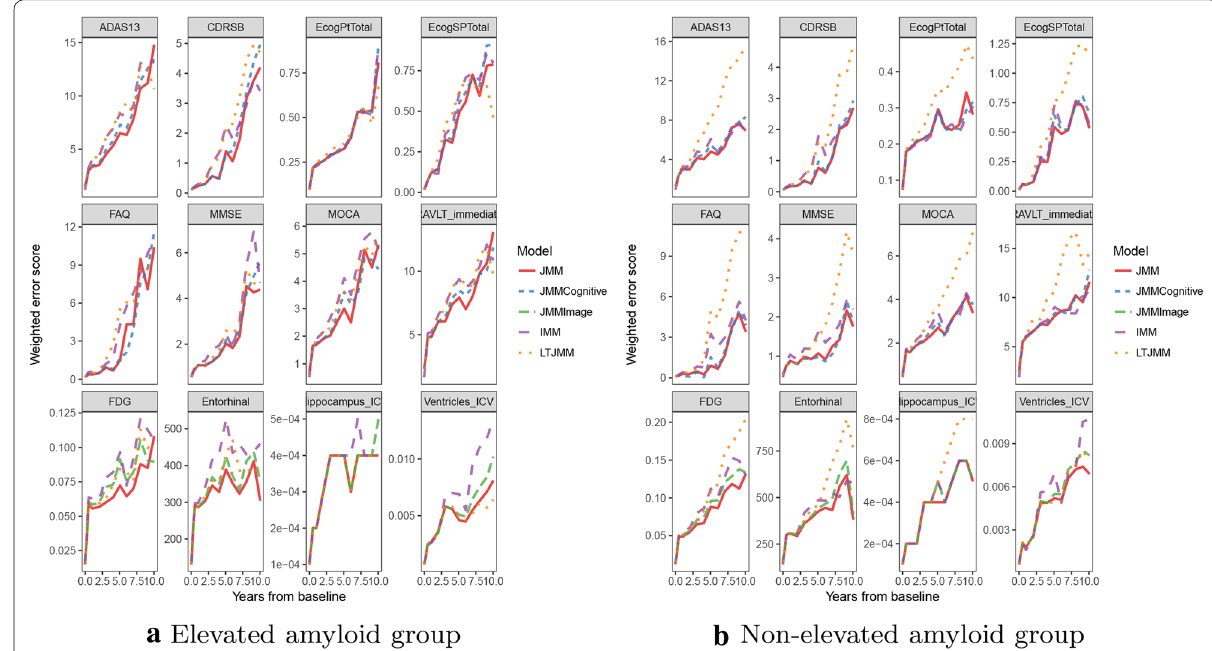
Fig. 11 Weighted error score for subset of the population with amyloid burden information. IMM Independent mixed-effects model, JMM joint mixed-effects model, LTJMM latent-time joint mixed-effects model